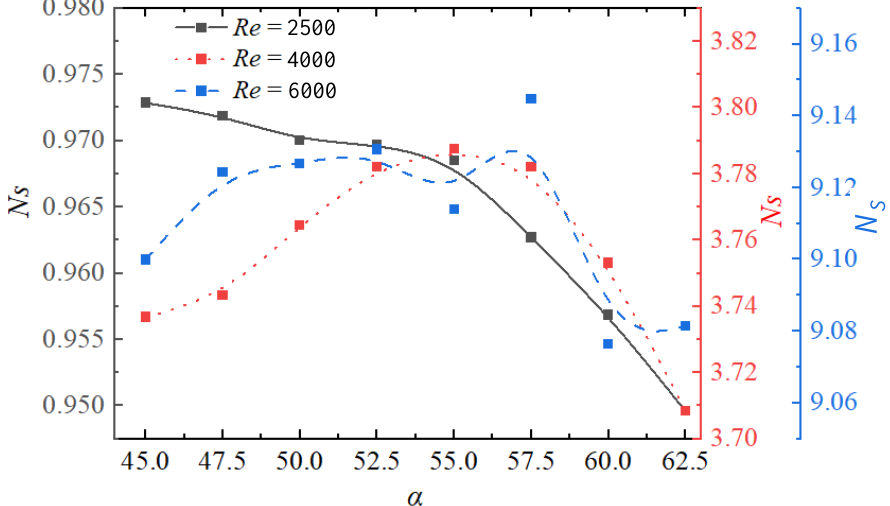
Figure 31. The irreversibility vs. A under different Re s ( A = tan 𝛼° , q = 1 kW/m 2 , and 29% Xe).